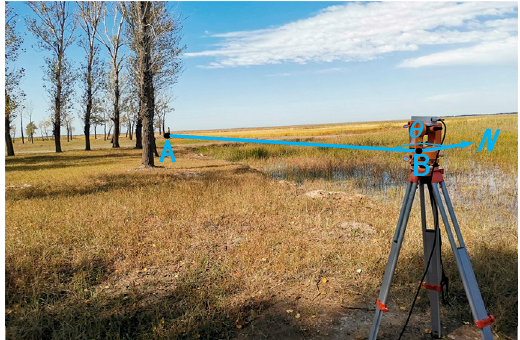
x -axis of magnetometer to the true north. t